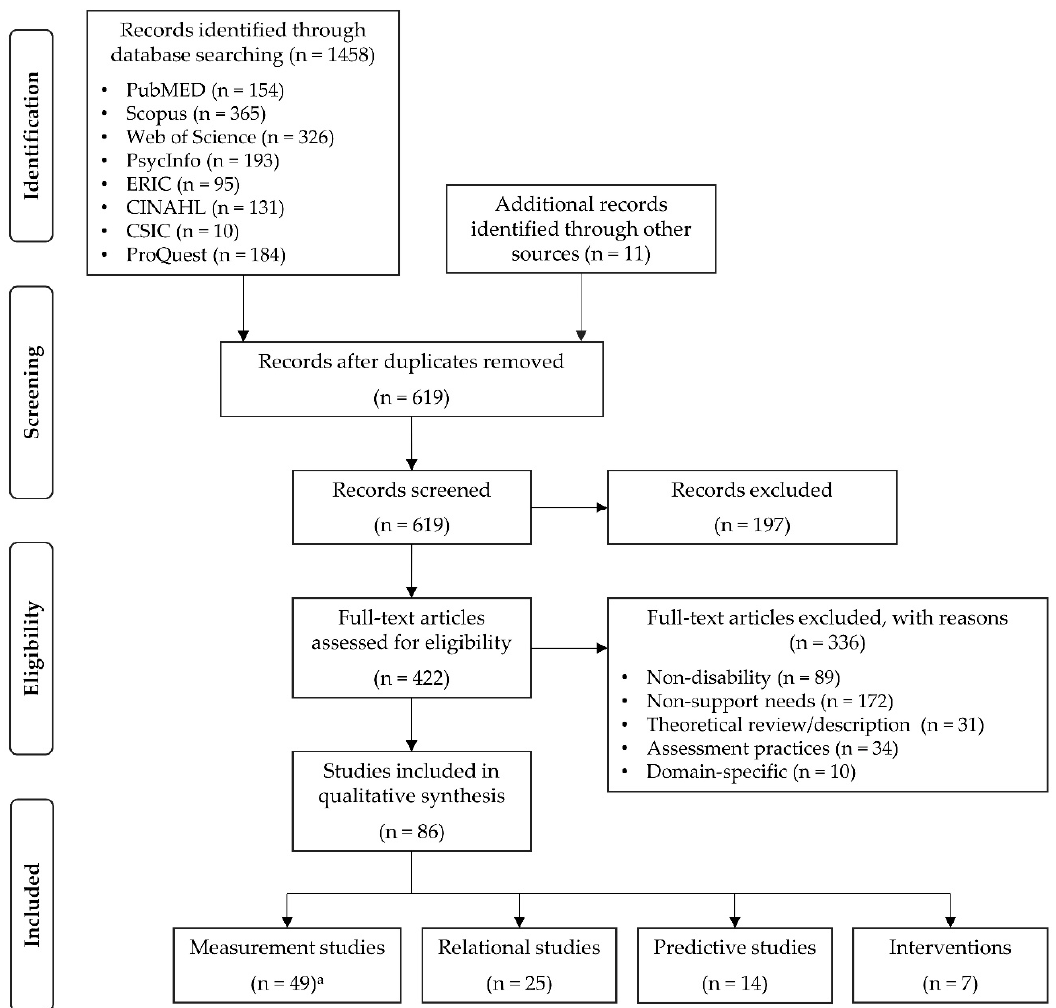
Figure 1. PRISMA flow diagram. a The measurement studies overlapped in 9 cases with the relational = 8) and predictive (n = 1) (n = 8) and predictive (n = 1) studies. (n